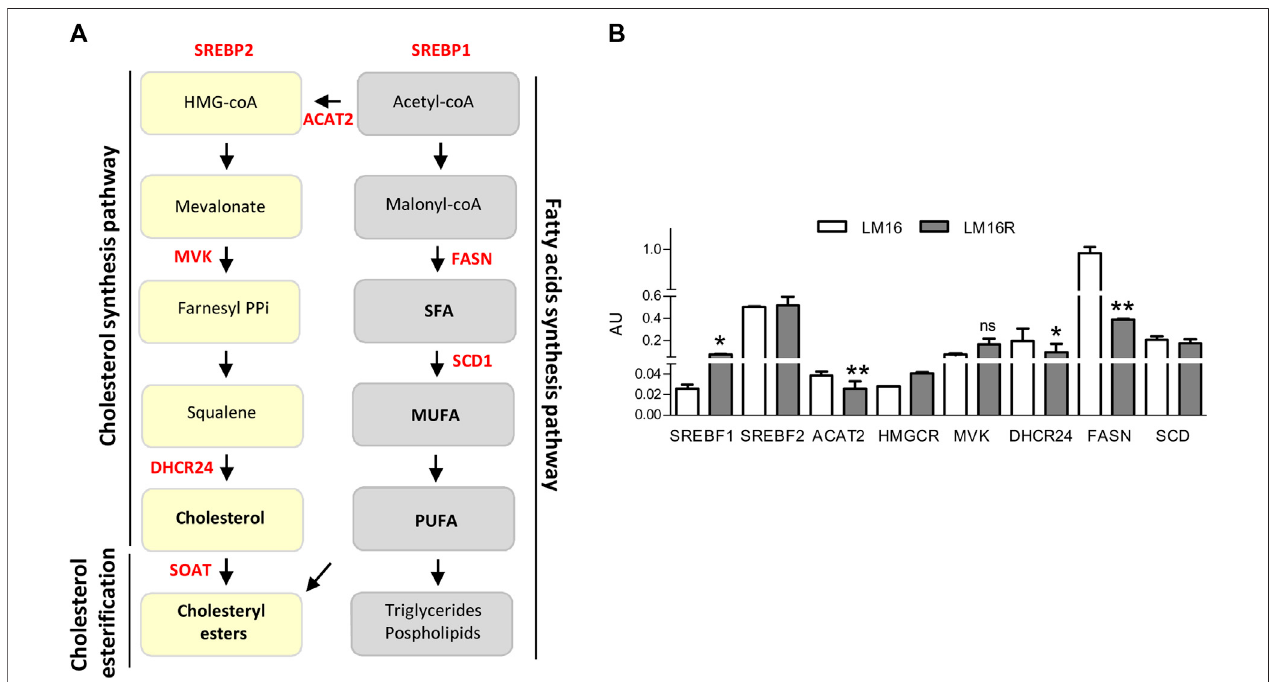
FIGURE 3 | Expression of lipid metabolism genes in LM16 and LM16R cell lines. (A) . Cholesterol and fatty acids synthesis pathways. Genes of interest are highlightedinred. (B) .Expressionlevelsoflipidmetabolism-relatedgenesinLM16RcomparedtoLM16celllineasevaluatedbyqRT-PCR.AU,ArbitraryUnits.* p < 0.05; ** p < 0.01 by unpaired Student ’ s t test. Determinations were repeated three times. ns: not signi fi cant.